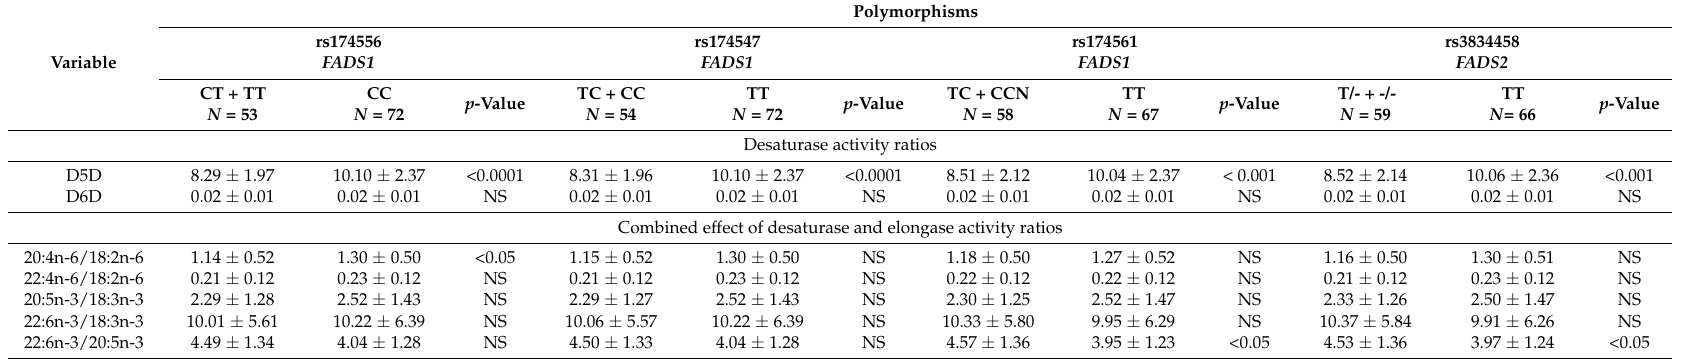
Table 6. Associations between FADS1 and FADS2 polymorphisms and desaturase and elongase